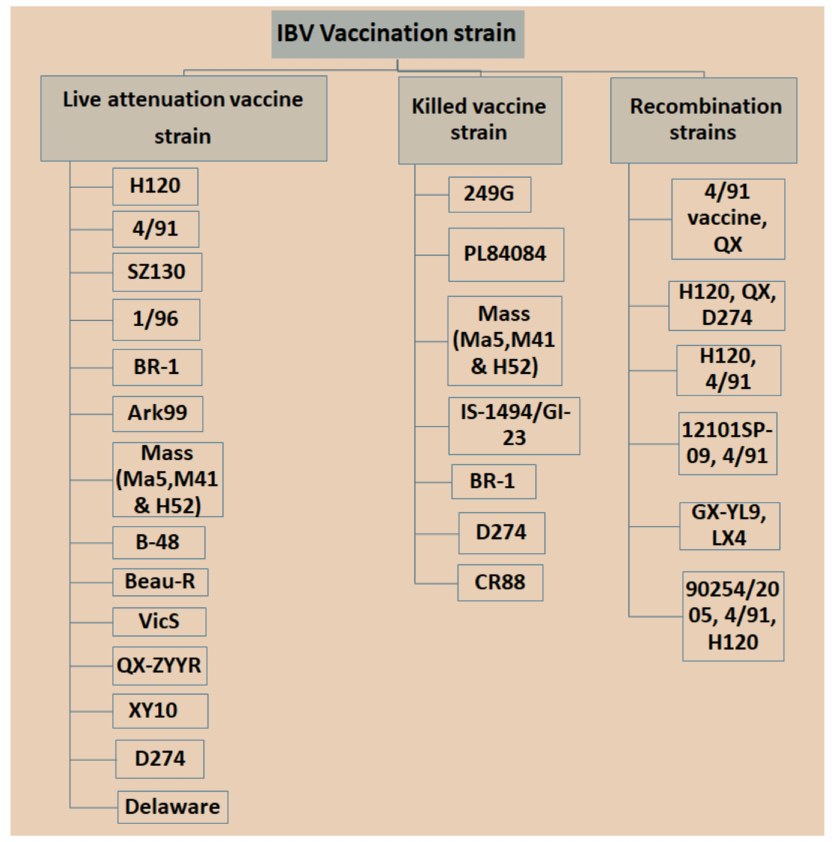
Figure 3. Different types of IBV vaccines are manufactured in the world based on the specific